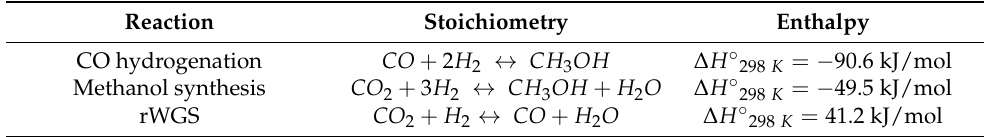
Table 23. Main reactions involved in the production of methanol from CO 2